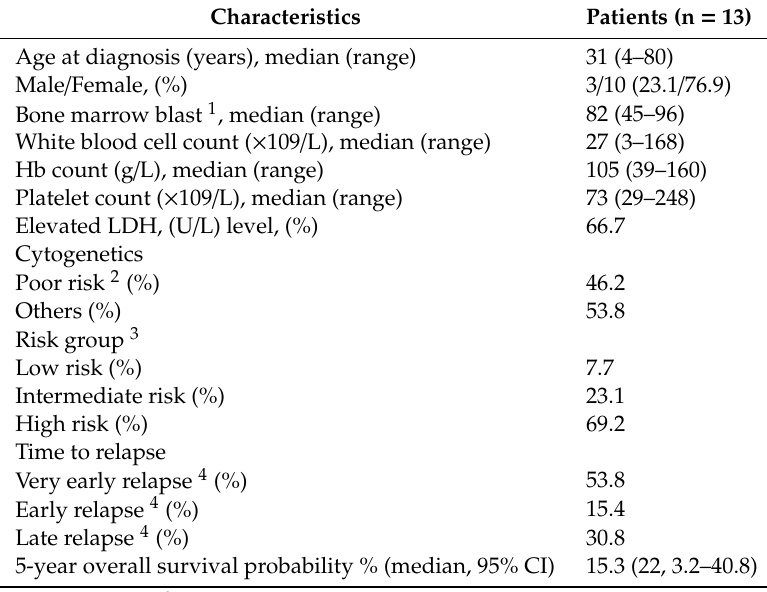
Table 1. Characteristics of the patients with B-cell precursor acute lymphoblastic leukemia (BCP-ALL) included in the